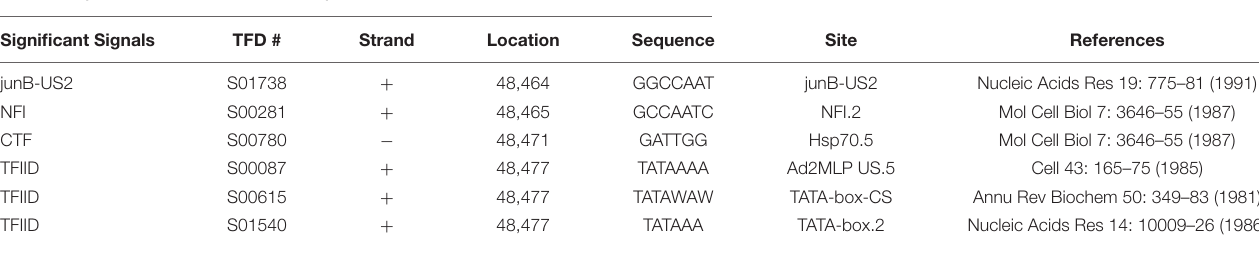
TABLE 1 | Promoter prediction of WY195 using